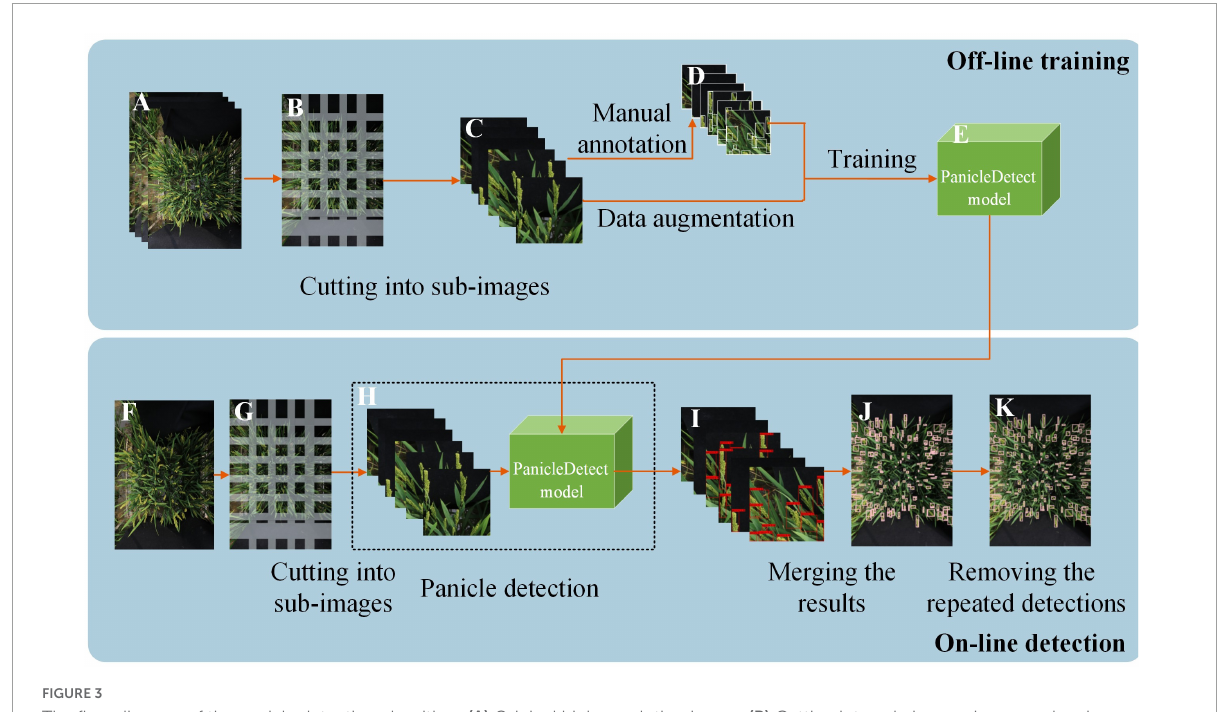
FIGURE3 The flow diagram of the panicle detection algorithm. (A) Original high-resolution image. (B) Cutting into sub-images in an overlapping manner. (C) Sub-images. (D) Manual annotation and data augmentation. (E) Panicle detection model generation. (F) Testing sample. (G) Cutting the testing sample into sub-images in an overlapping manner. (H) Feeding the testing sub-images into the Panicle detection model. (I) Panicle detection results of the sub-images. (J) Panicle detection result after merging the detection results of the sub-images. (K) The final detection results of the original image after deleting the repeated detections in the overlapping area of the adjacent sub-images.